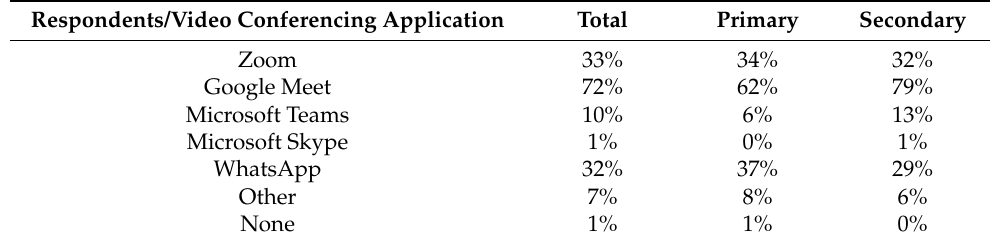
Table 11. Video conferencing or meeting software used for teaching during the COVID-19 pandemic (question 6).